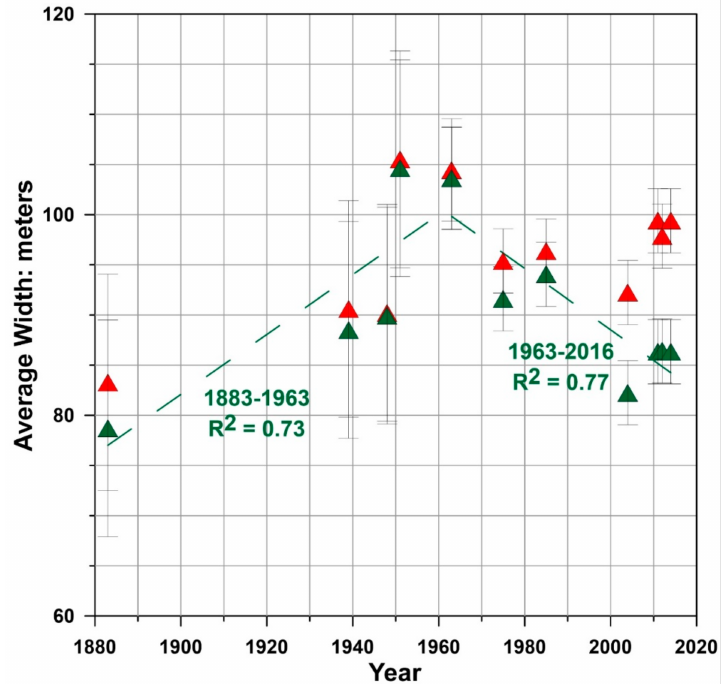
Figure 8. Average width of the barrier based on all transects (red triangles) and transects 20–25 and 31–50 (green triangles). Transects 26–30 were excluded because the dynamics of the small spit on the western bayside of the barrier (see Figure 1, Figure 6, Figure 9 and supplemental materials) alter the barrier width of the 2004–2018 shorelines. See the text for a more detailed discuss of why transects were excluded. The dashed green line represents linear best fit of the data between 1883–1963 and 1963–2016. Error bars are based on the shoreline position uncertainty reported in Table